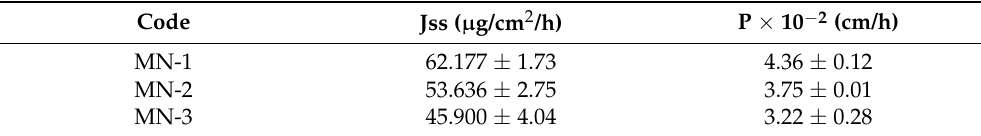
Figure 11. The cumulative amount (%) of ALS permeated through rat skin versus time (t) for MN-1, MN-2, MN-3, and F4 for 60 h (mean ± SD, n = 3). Table 9. Drug permeation parameters (Jss and P) from different DMN formulations (mean ± SD, n =